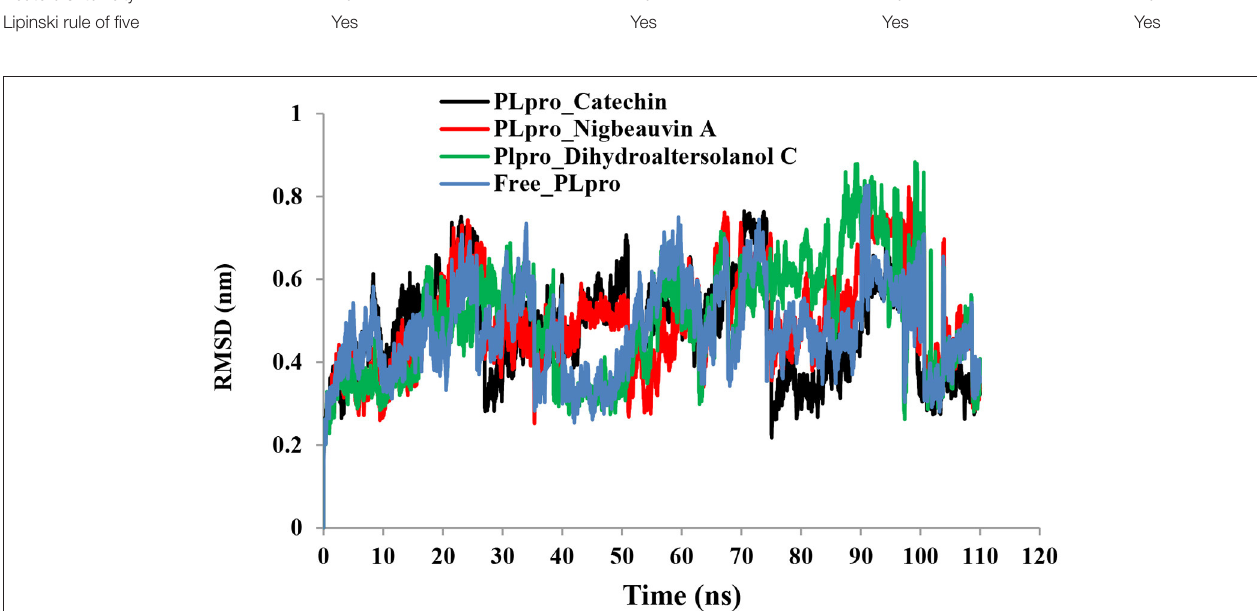
FIGURE 2 | Time run root-mean-square deviation (RMSD) value analyses for the simulated PLpro-ligand complex and Free-PLpro alpha carbon atoms systems. PLpro-Catechin code: black, PLpro-Nigbeauvin A code: red, PLpro-Dihydroaltersolanol C code: green, and Free-PLpro code: blue.